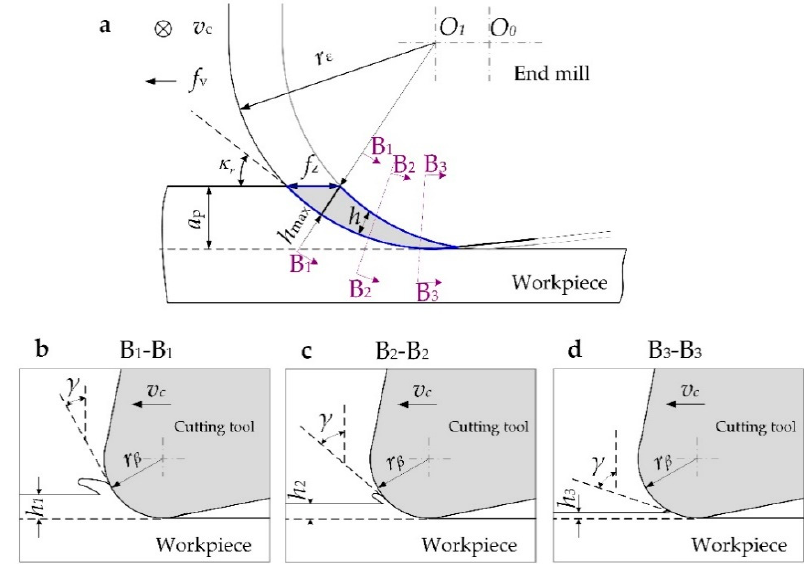
Figure 2. Schematic of ( a ) cutting zone in precision milling and the cross-section view of the uncut chip thickness at different position of ( b ) B1, ( c ) B2 and ( d ) B3.